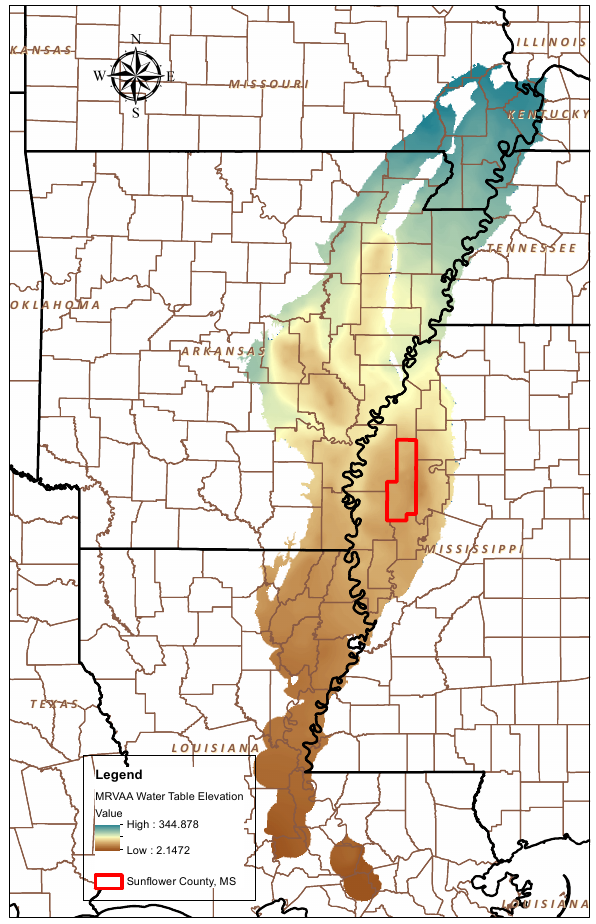
Figure 2. Potentiometric map of the Mississippi River Valley Alluvial Aquifer based on U.S. Geologi- cal Survey data from